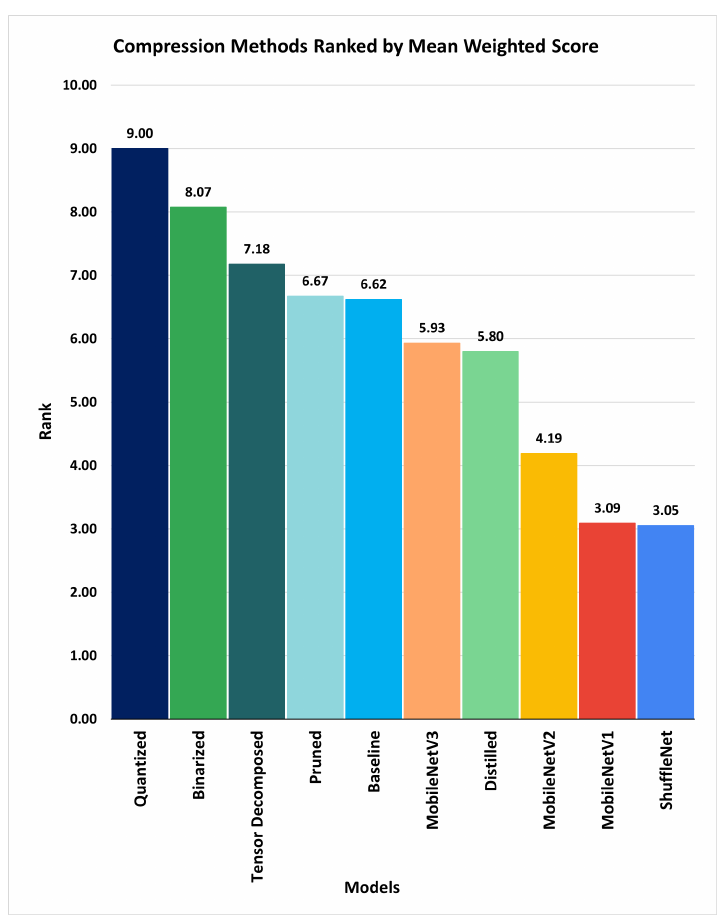
Figure 6. Compression methods ranked by the mean weighted